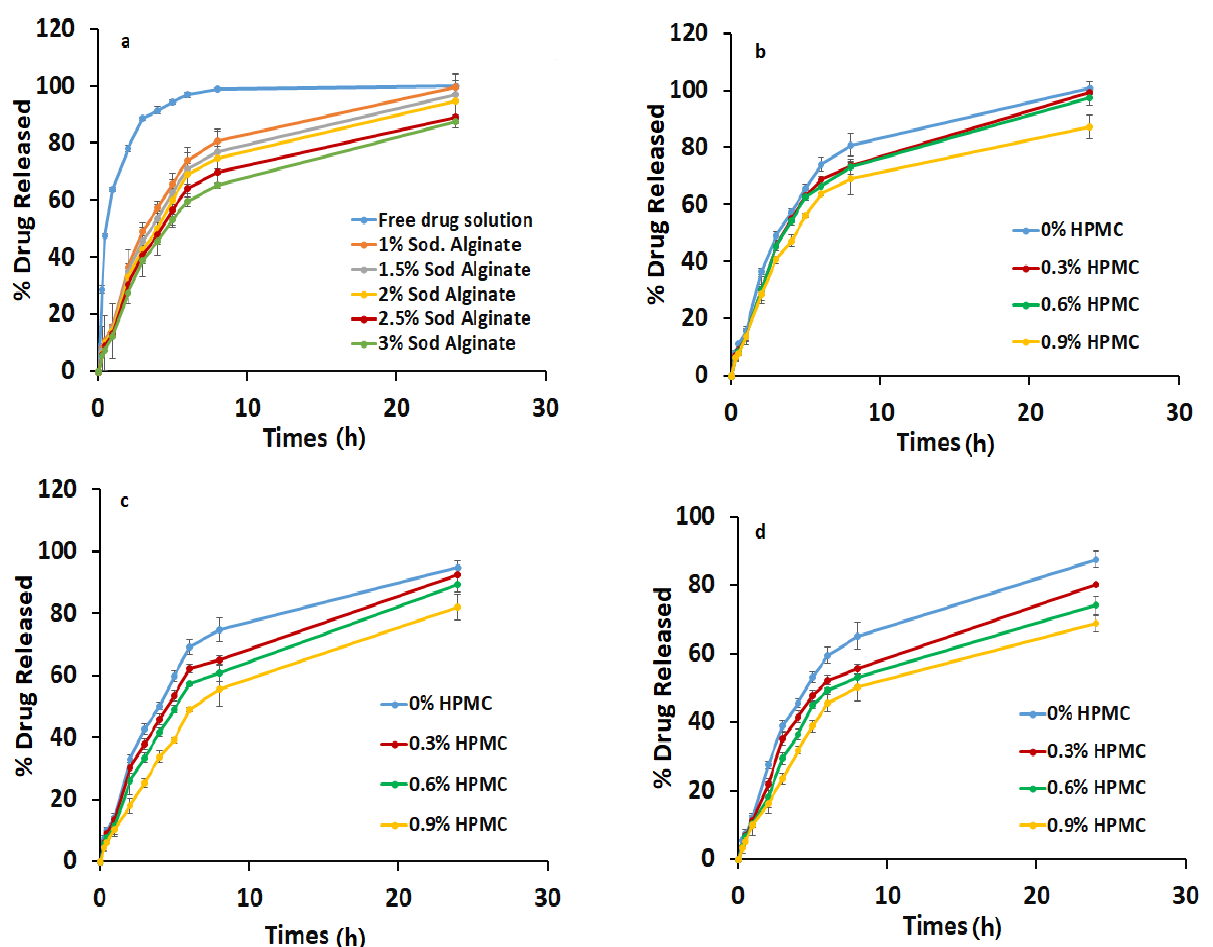
Figure 2. ( a ) Effect of Na alginate concentration on the in vitro release of BH from in situ gelling formulations. Effect of HPMC concentration on the in vitro release of BH from in situ gelling formulations containing ( b ) 1% Na alginate, ( c ) 2% Na alginate, and ( d ) 3% Na alginate.